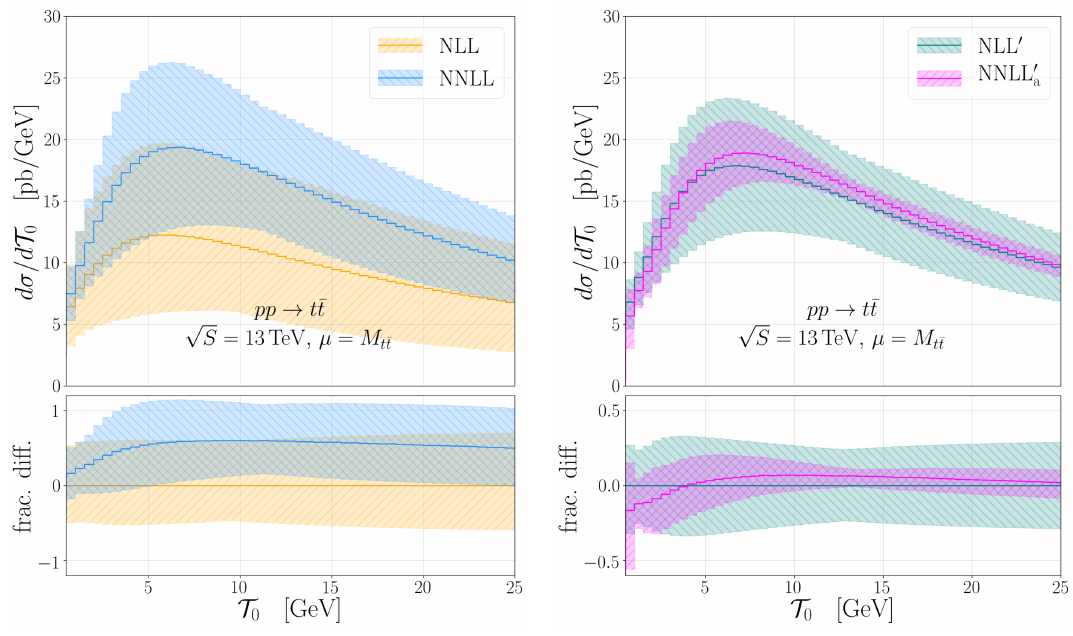
prediction shown on the right misses a